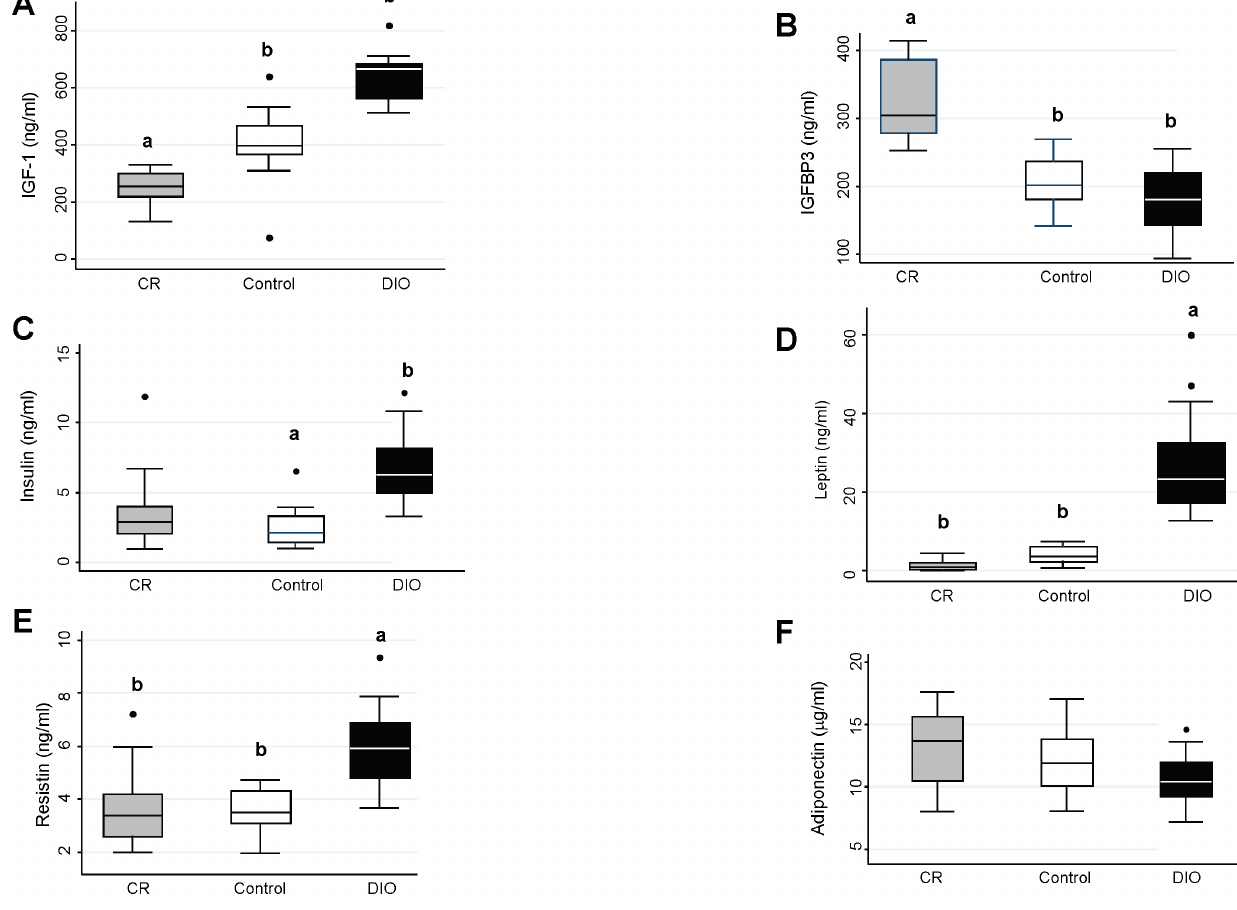
Figure 5. Adipokine, IGF-1, IGFBP-3, and insulin levels among CR, control, and DIO mice. Levels of A ) IGF-1, B ) IGFBP-3, C ) insulin, D ) leptin, E ) resistin, and F ) adiponectin were measured in the serum of the mice ten weeks after the last injection of AOM. Each boxplot represent the mean and range (n=20). Overall differences among groups were determined using a one-way ANOVA. For A ) IGF-1, p=0.002; B ) IGFBP-3, p , 0.001; C ) insulin, p=0.002; D ) leptin, p , 0.0001; E ) resistin, p=0.001; and F ) adiponectin, p=0.14. a , b , and c represent dietary treatments that are significantly different (p , 0.05) from one another as determined by a Bonferroni test.